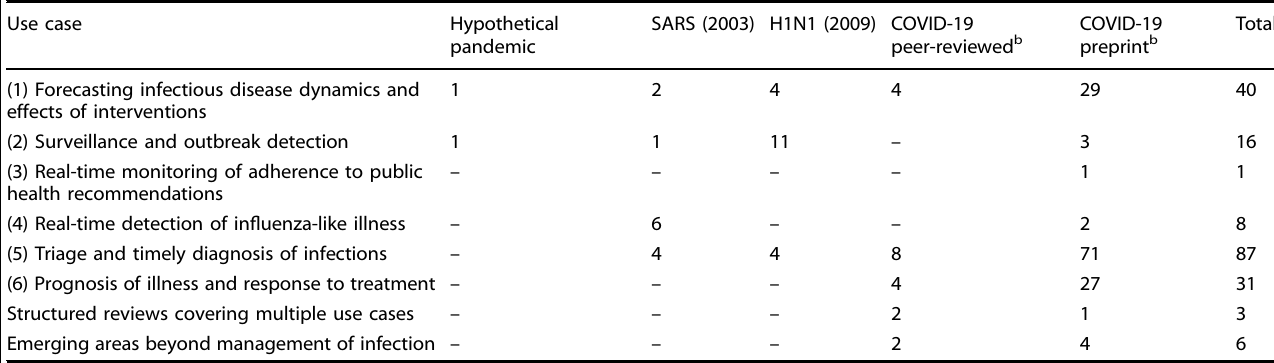
Table 1. Number of manuscripts included in the in-depth review by use case and respiratory pandemic or SARS global outbreak a . Use case